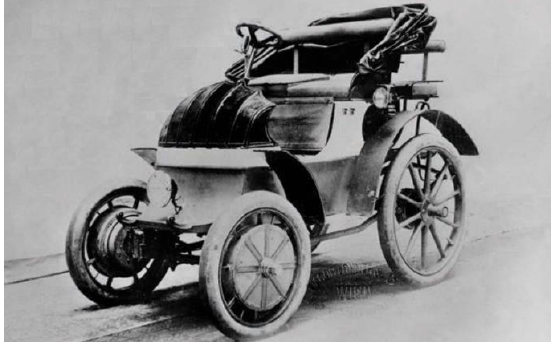
Fig. 1. The in-wheel motors vehicle developed by Lohner and Porsche in 1898 [10]